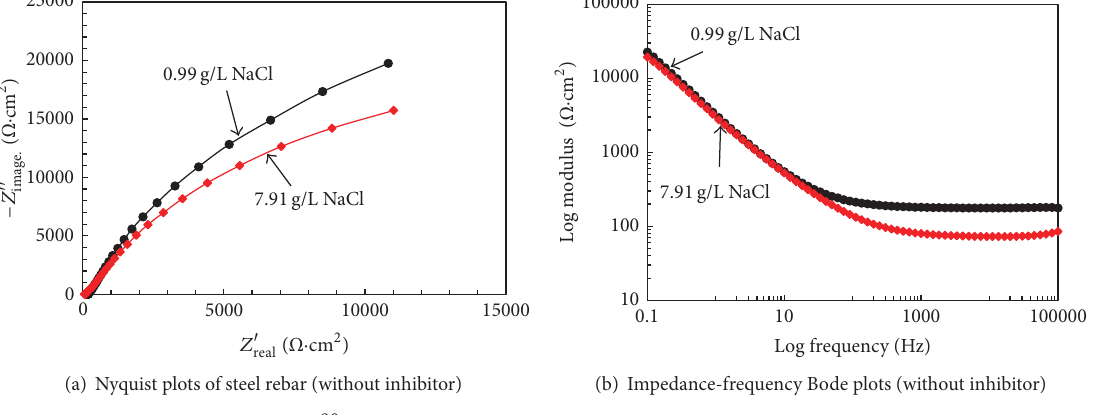
(b) Impedance-frequency Bode plots (without inhibitor)